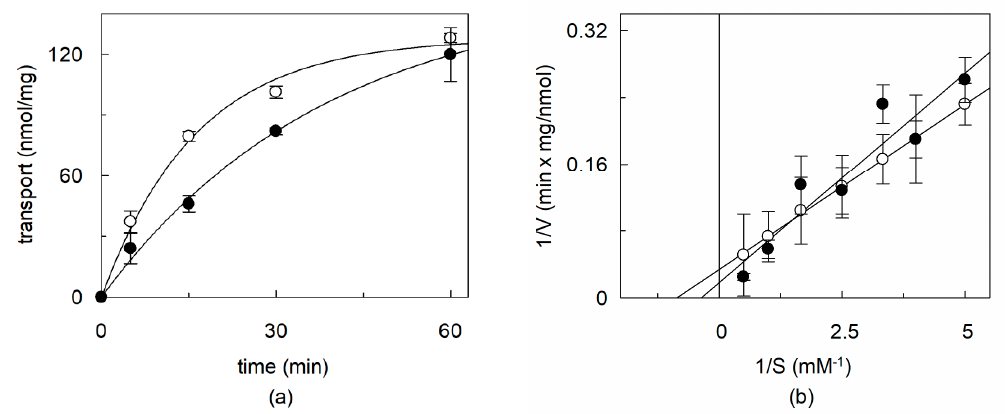
Figure 2. E ff ect of cholesterol removal from proteoliposomes on the recombinant OCTN1. The recombinant purified OCTN1 was reconstituted in liposomes as described in Section 4.5. Proteoliposomes were incubated in the absence ( ○ ) or in the presence of 10 mM M β CD ( ● ). (a) Transport was started adding 0.1 mM [ 14 C]-TEA at time zero to proteoliposomes and stopped at the indicated times as described in Section 4.7. Time course data were interpolated in a first order rate equation. (b) The transport rate was measured adding [ 14 C]-TEA at the indicated concentrations to proteoliposomes. The transport reaction was stopped at 10 min, i.e., within the initial linear range of the time course. Data were plotted according to Lineweaver–Burk as reciprocal transport rate vs reciprocal TEA concentration. The values in both ( a ) and ( b ) are means ± SD from three different experiments.